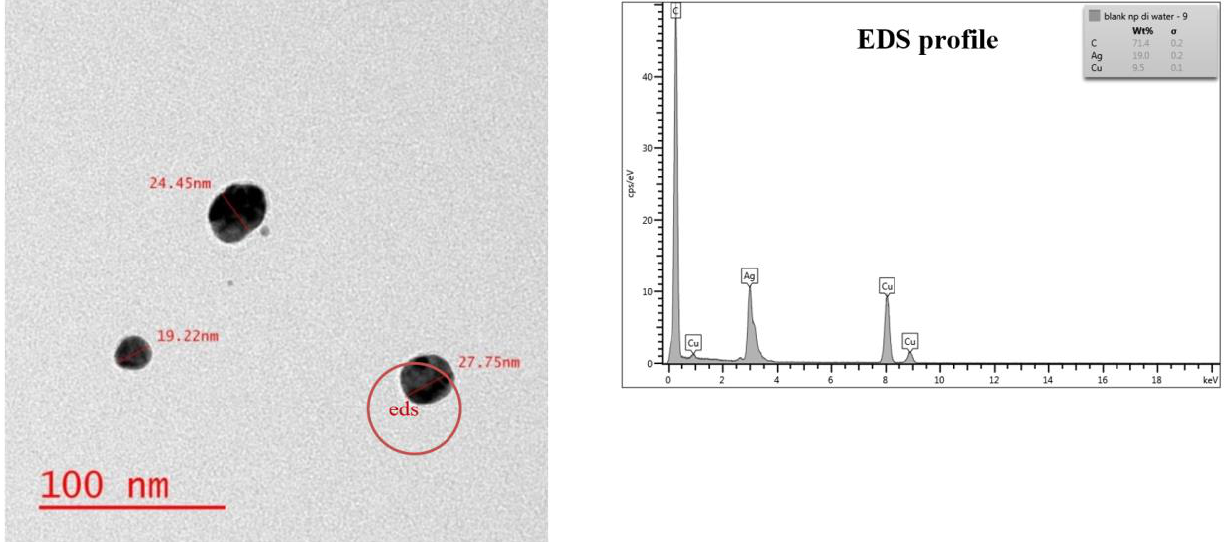
Figure 1. TEM image of AgNPs suspended in water with its EDS profile.